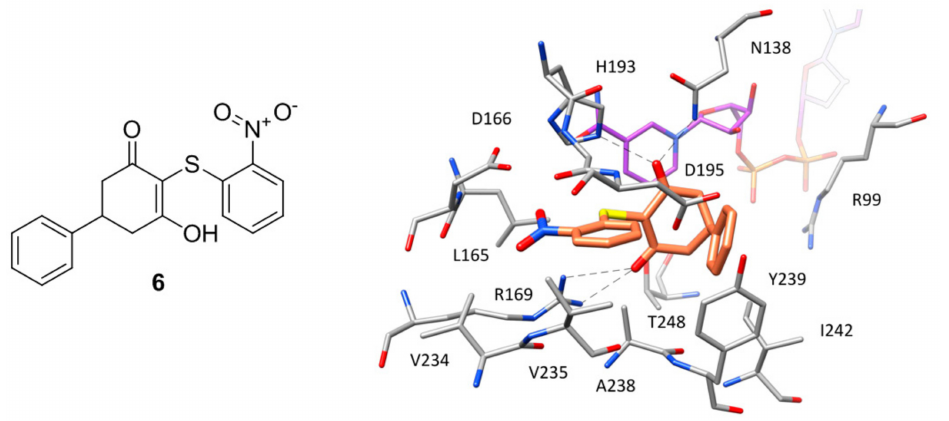
Figure 5. Chemical structure of 6 and X-ray structure of h LDH5 in complex with compound 6 (PDB code 4QO7). The cofactor and active site residues interacting with the inhibitor are shown and the ligand–protein H-bonds are